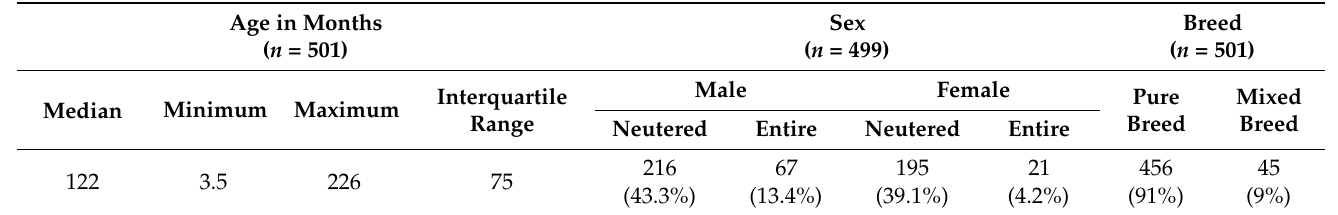
Table 2. Characteristics of a hospital population of dogs in Hong Kong from which whole-blood DNA was tested for domestic cat hepadnavirus via qPCR.